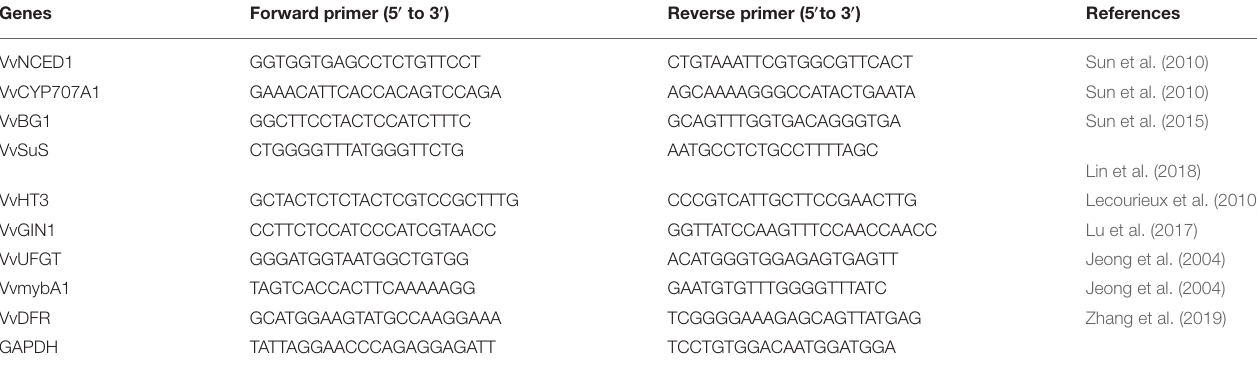
TABLE 1 | Details of the qRT-PCR